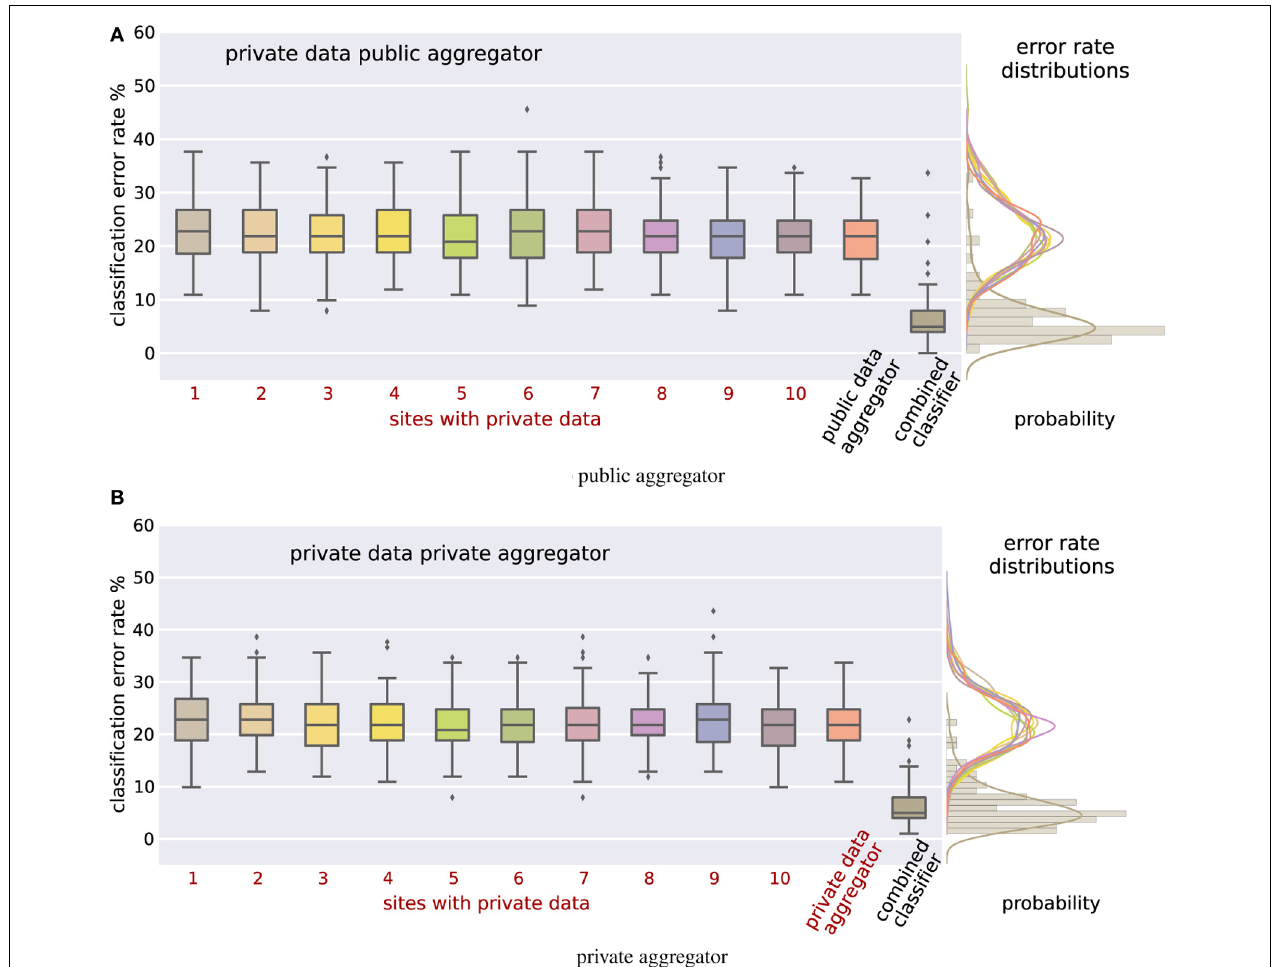
FIGURE 2 | Classification error rates for the mixed private-public case (A) and the fully-private case (B). In both cases the combined differentially private classifier performs significantly better than the individual classifiers. The difference is statistically significant even after Bonferroni correction (to